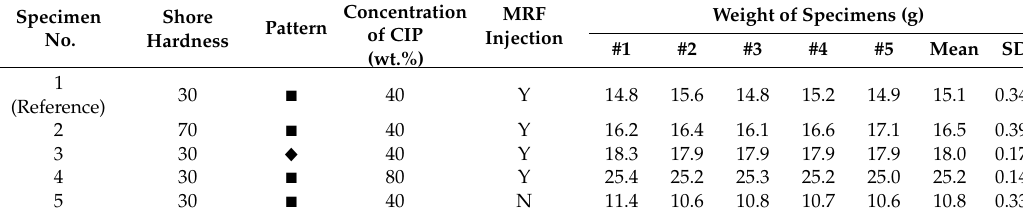
Figure 5. Pictures of the manufactured soft composites: ( a ) rectangular pattern, ( b ) rhombus pattern, and ( c ) bent shape. Table 1. Mean and standard deviation of the weight per